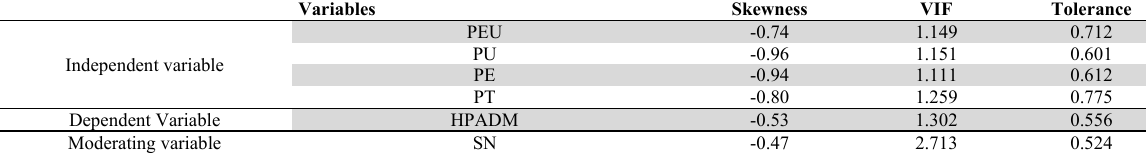
The suitability of research data to test hypotheses analysis using VIF